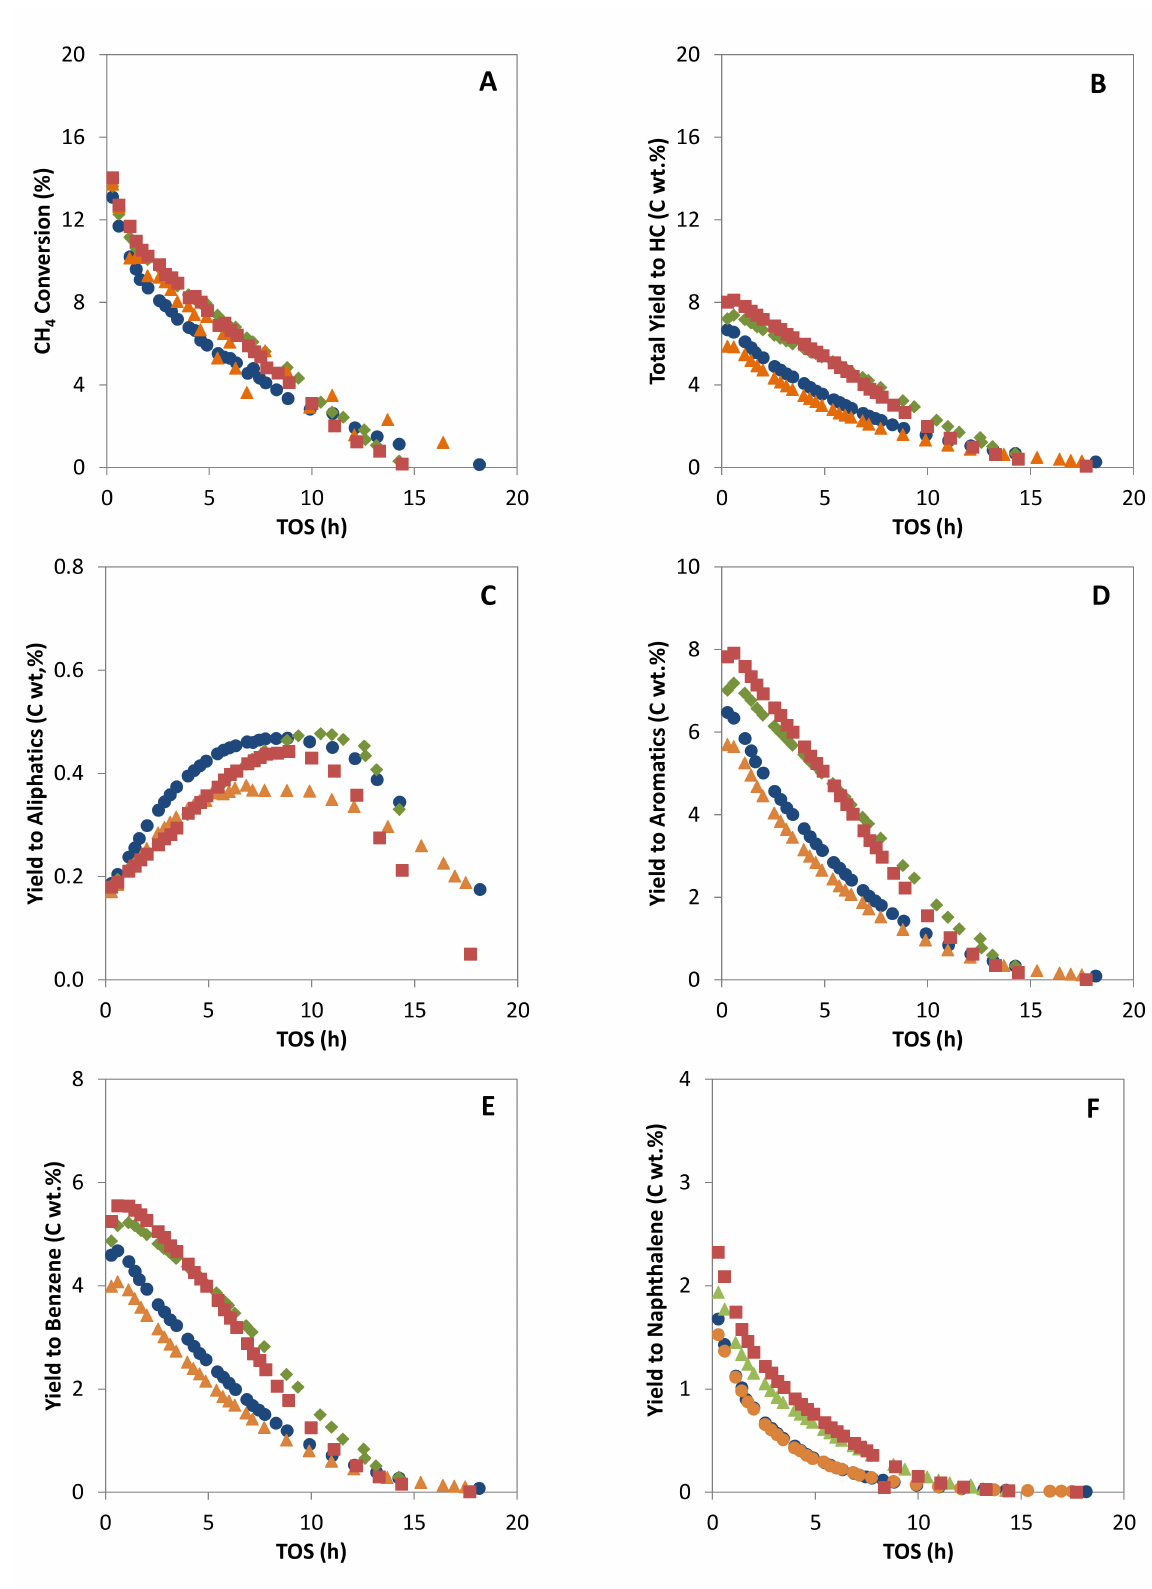
Figure 4. Methane conversion ( A ), total yield to hydrocarbons products ( B ), yield to aliphatic hydrocarbons ( C ), to aromatic hydrocarbons ( D ), to benzene ( E ) and to naphthalene ( F ) versus TOS for catalysts MoZ5-SSR-SC ( ), MoZ5-SSR-DC ( ), MoZ5-IW-SC ( ), and MoZ5-IW-DC ( ), at 973 K, atmospheric pressure and w/F = 16 g·h/mol. Despite the comparable initial conversion, the two catalysts obtained by calcination under static conditions, MoZ5-IW-SC and MoZ5-SSR-SC, present a higher deactivation